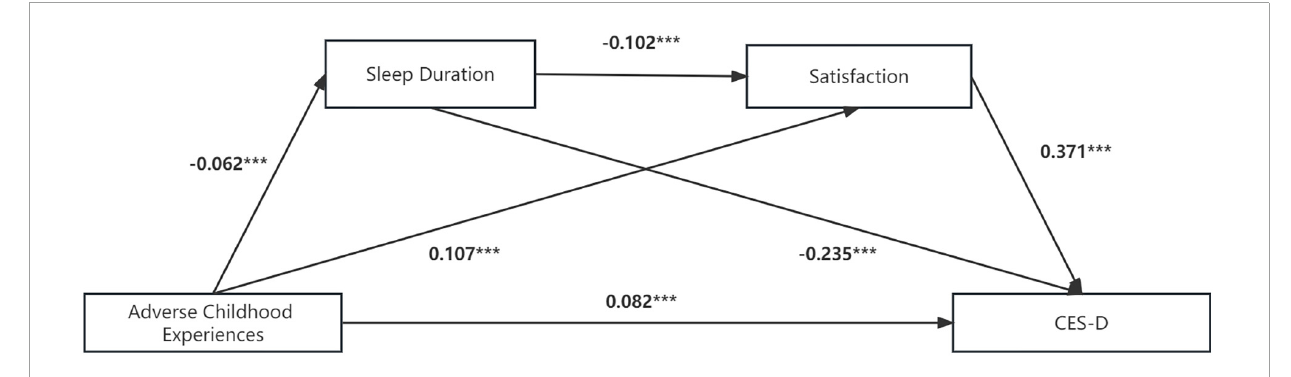
FIGURE2 Multiple mediation model between adverse childhood experiences and CES-D scores with sleep duration and life satisfaction as mediators. Path values are the path coefficients. CES-D, Center of epidemiologic studies depression scale. *** P < 0.001.